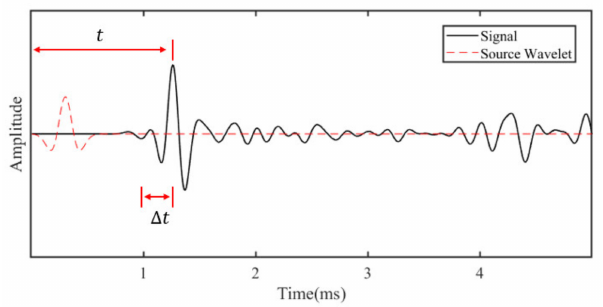
Figure 24. Signal advance correction to match the peak time to the arrival time.